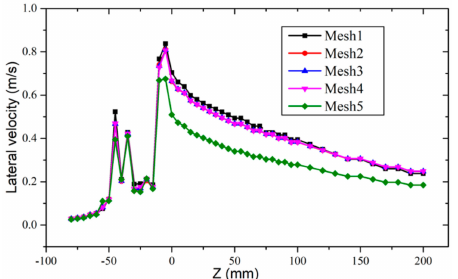
Figure 5. Distribution of the lateral velocity for di ff erent meshes.